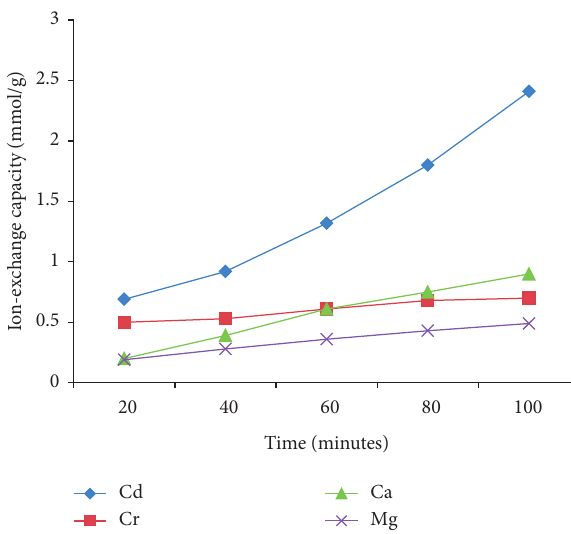
Figure 7: Effect on contact time for IEC on the SCF resin.